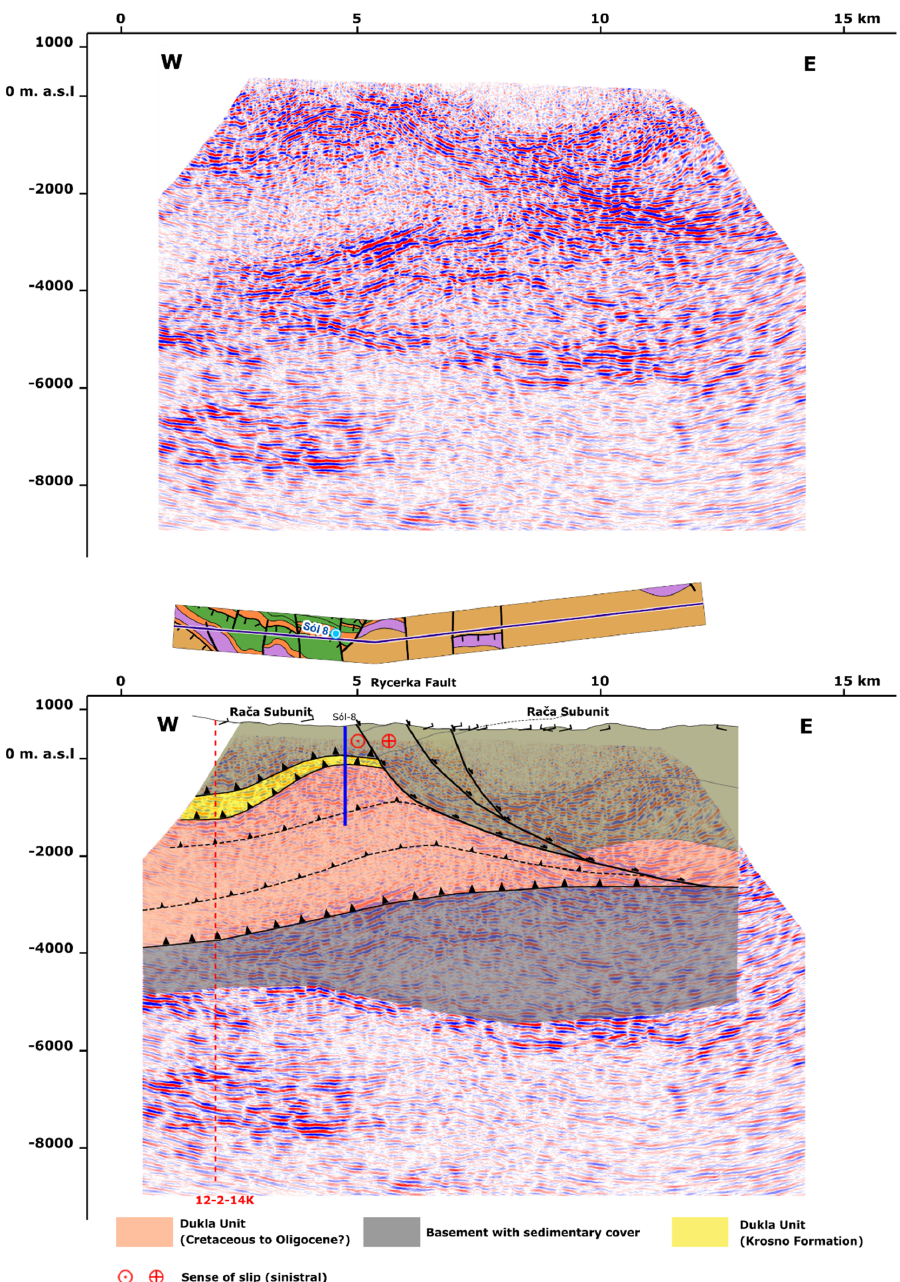
Figure 14. Depth Migrated seismic profile 8-2-14K (upper panel) and its interpretation (lower panel). The black vertical line indicates an intersection with the 12-2-14K seismic profile. Black lines—normal and thrust faults, dashed black lines—anticipated second-order thrust within the anticlinal stack. Red line—intersection with the 12-2-14K seismic profile. Above the interpreted seismic profile a fragment of the geological map is presented. Colour coding as in Figure 13. Abbreviation: m. a.s.l—meters above sea level.